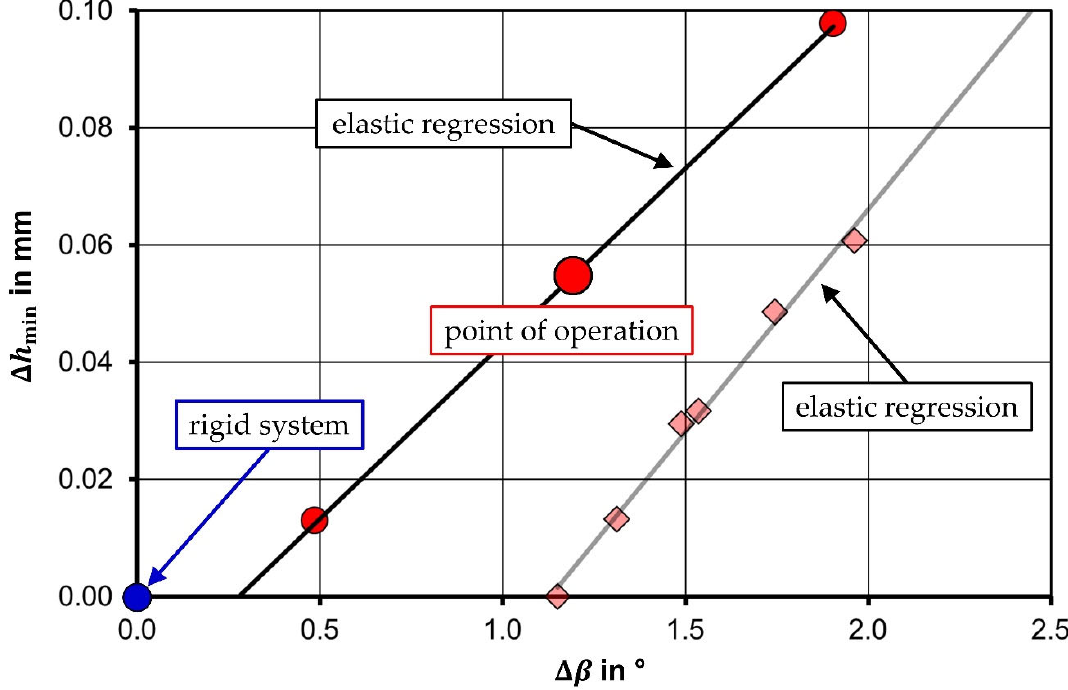
Figure 4. Elastic behavior of the Couette apparatus: rigid system vs. elastic system [24] with increased